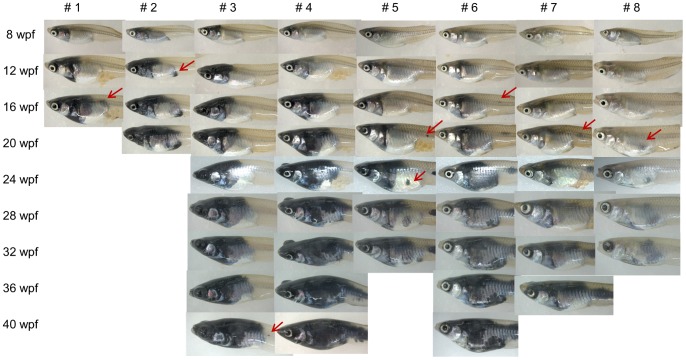
Characteristics of Tg
(
tyr:HRASG12V
)/Tg
(
hsp:cre
) medaka.Age-dependent changes in eight double-transgenic fish were monitored after heat treatment at 1 wpf. Five of the eight fish manifested hyperproliferation of pigment cells around the eyes by 8 wpf. All of the fish had developed MPLs with characteristics of infiltrative tumors by 20 wpf, and all had died by 43 wpf. Arrows indicate the first appearance of metastasis-like lesions.